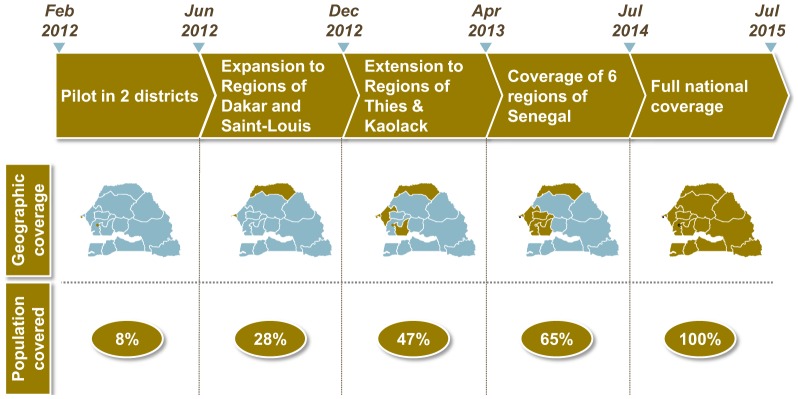
National IPM Scale-Up Plan, SenegalAbbreviation: IPM, informed push model.